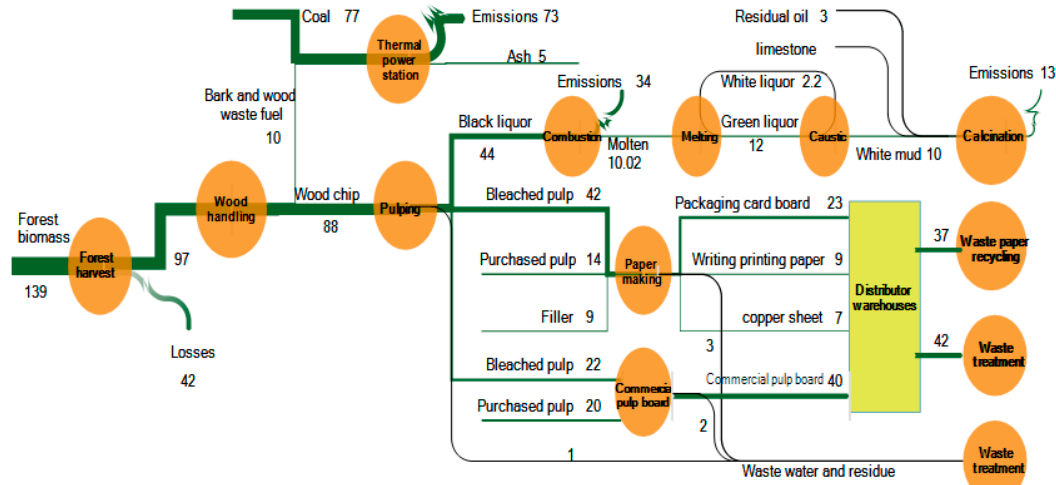
Figure 9. Embodied carbon flows based on product life cycle (unit: 10,000 t